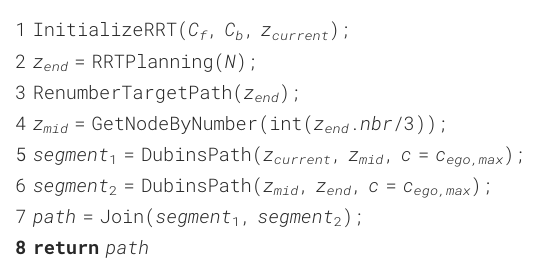
Algorithm 4. Junction Vehicle Passing Algorithm.